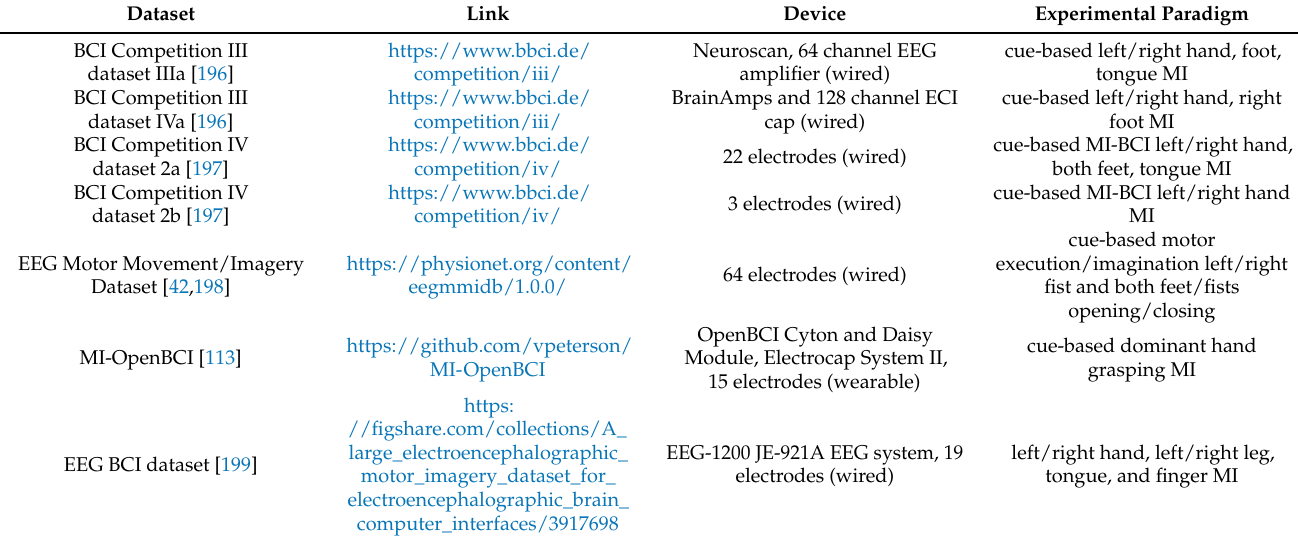
Table 6. Summary of the publicly available datasets employed by some of the reviewed papers. In the Dataset field are reported only the citations directly related to the dataset